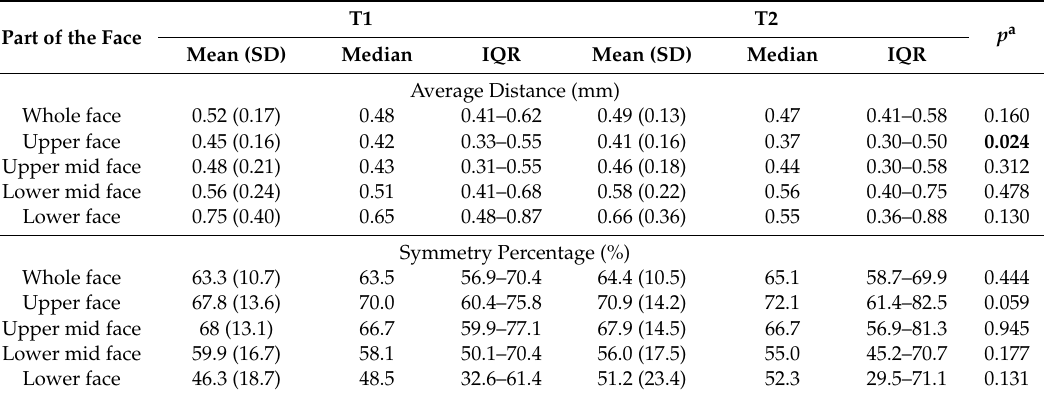
Table 1. The course of facial symmetry measured with surface-based variables: average distance (mm)